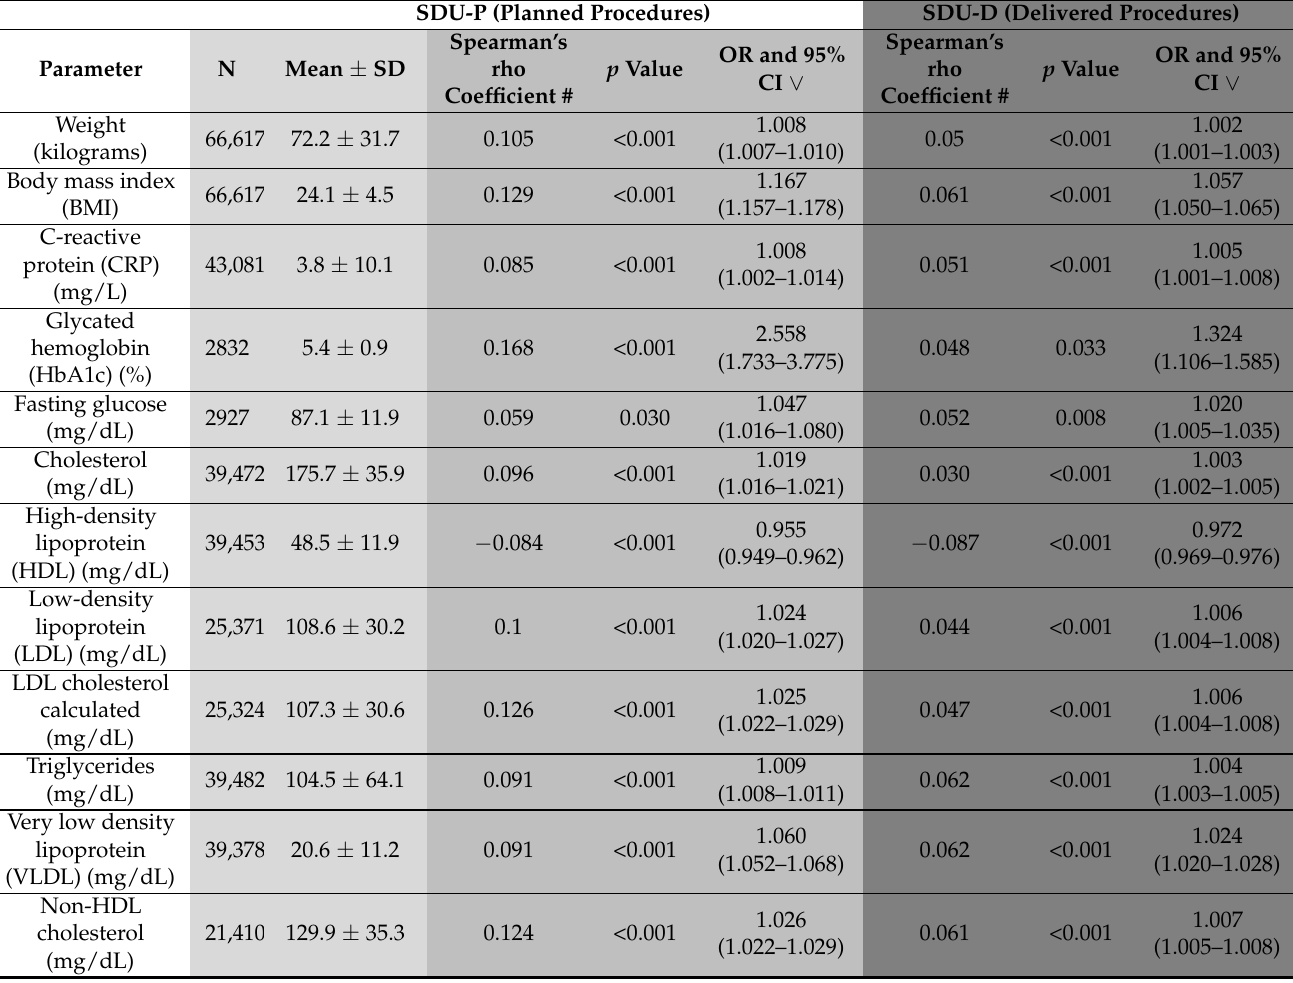
Table 4. The correlations of SDU-P (planned procedures) and SDU-D (delivered procedures) with auxiliary test results, including blood tests, used in the assessment of MetS components. # Spearman’s correlation, ∨ general linear